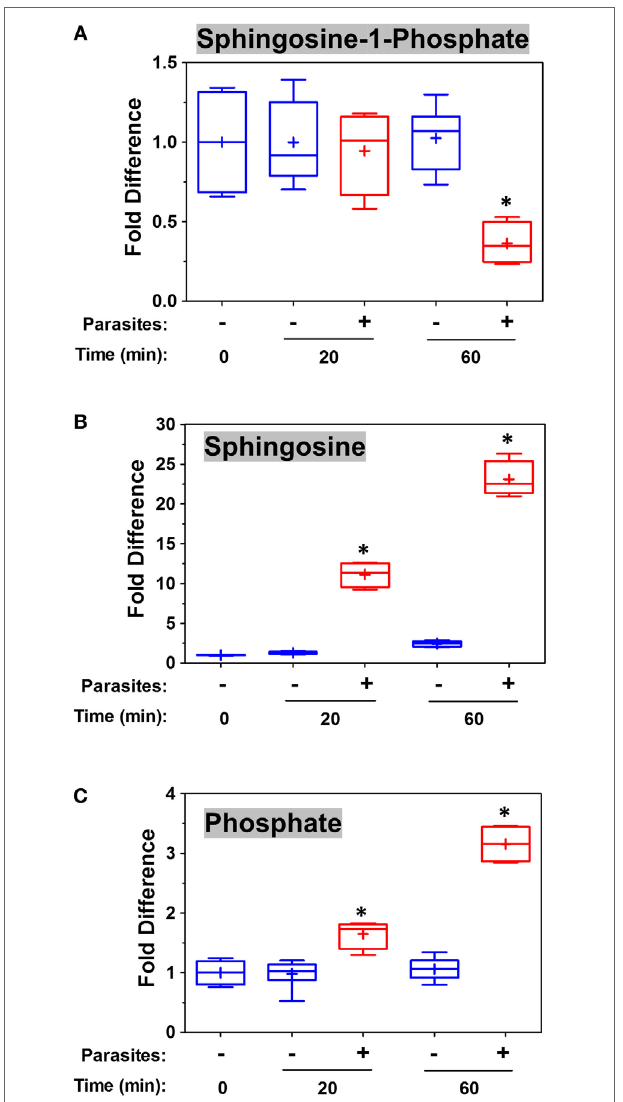
FigUre 5 | Box plots showing relative differences in the levels of Sphingosine-1-Phosphate [ (a) , top], Sphingosine [ (B) , middle], and Phosphate [ (c) , bottom] in murine plasma that either contained adult schistosomes ( + , red) or did not contain schistosomes ( − , blue) for the indicated time periods. * indicates statistically significant difference compared to the same time point lacking parasites; Welch’s two-sample t -test, p < 0.05. Each box bounds the upper and lower quartile, the line in each box is the median value and “ + ” signifies the mean value for the sample; error bars indicate the maximum (upper) and minimum (lower) distribution. Values obtained at zero time (0) are set at